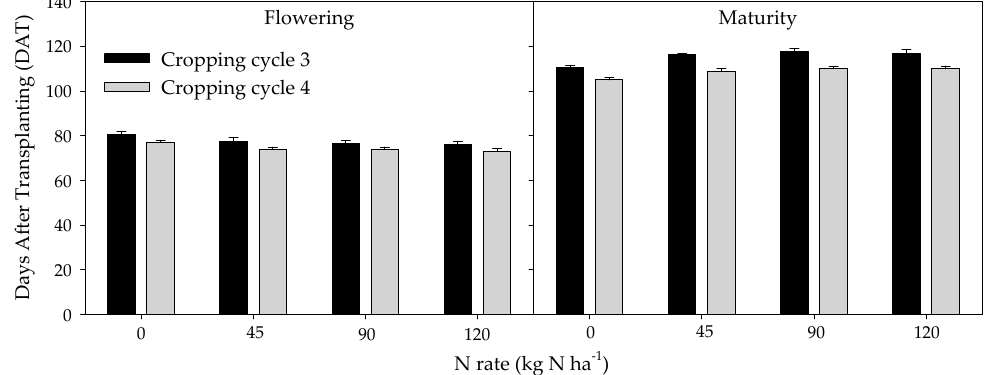
Figure 2. Effects of N fertilizer and sowing time on the number of days rice plants took to flower and mature in the 2013–2014 cropping cycle at Kpong, Ghana. DAT: Days after Transplanting. The 3rd cropping cycle was from July to November while the 4th cropping cycles spanned the period December to April.